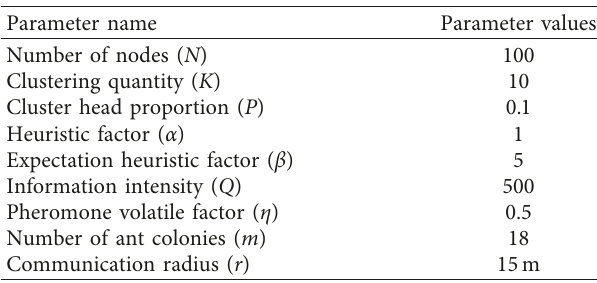
Table 1: Simulation parameter.